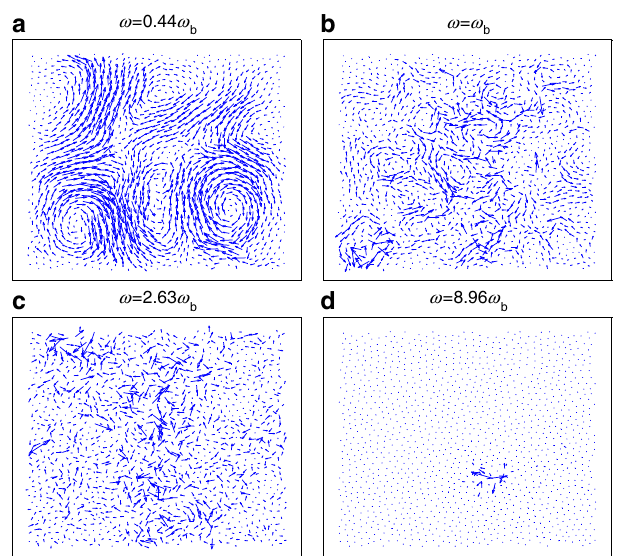
Fig. 3 Spatial distributions of modes. The spatial distributions of the modes at ω / ω b = 0.44 a , 1.0 b , 2.63 c , and 8.96 d . The participation ratios are p ( ω n ) = 0.44 a , 0.3 b , 0.244 c , and 0.00499 d . Here p ω n ð Þ (cid:3) where e n , i is the polarization vector of the particle i in the n th mode (see, e.g., ref. 8 ). Note that the magnitudes of the polarization vectors in different modes are shown at different scales